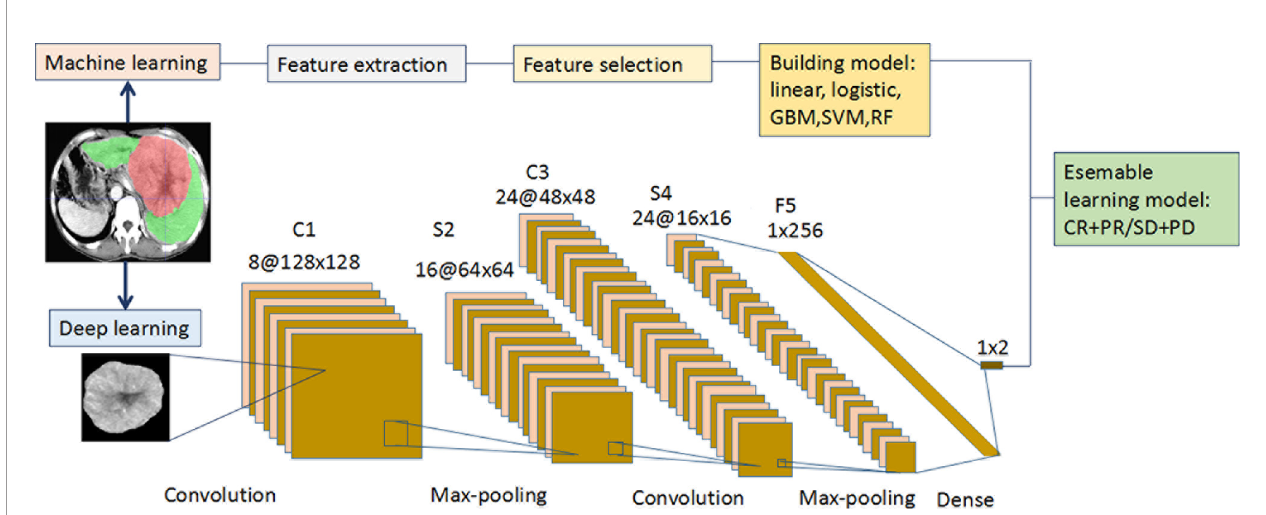
FIGURE 1 | Flowchart for the integration of the machine learning and deeplearning models. (i) The radiologists manually segmented the 3D ROIs ofHCC using ITK-SNAP. Thereafter,1167 features were extracted from the hepaticarterial CT images based on the “ pyradiomics ” packageof python.Redundantradiomics features werethen eliminatedby ICCs. Using RFE and 5-foldcross-validation,the fi nalfeatures were selected and the fi ve radiomics modelswere builtusing different machine learning algorithms. (ii) A CT image andmaskof ROI manuallysegmentedfromthe largest tumorlayer was resized and output as 224 × 224 ×3 fromeach patient in the two cohorts. Augmentation techniques were used to enlarge the training CT image dataset, and “ new ” big data were generated. The deeplearning framework included two convolutions, two max-poolings, and one dense layer. The fi nal output layer was a softmax classi fi er.The optimizer was Adam,with a learning rate of 0.001 andbatch size of 16. All the layerswere standardized and the L2 regularization was set to 0.000001. The activation function ofRELUwas set as alpha = 0.1. (iiiEach of the fi ve machine learning models (linear,logistic, GBM, SVM,and RF) was integrated with the deeplearning model to predict the initial treatment response to TACE. CT, computed tomography;GBM, gradient boosting machine; HCC, hepatocellular carcinoma; ICC, intraclass correlation coef fi cient; RELU, reconstructedlinear units; RF, random forest; RFE, recursive feature elimination;ROI, region of interest; SVM,support vectormachine; TACE, transarterial